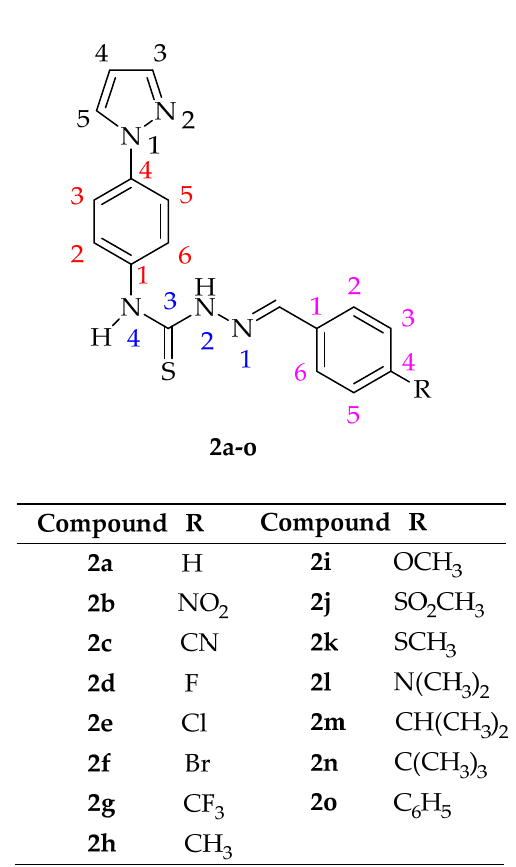
Figure 4. The diagram for NMR data of compounds 2a – o .